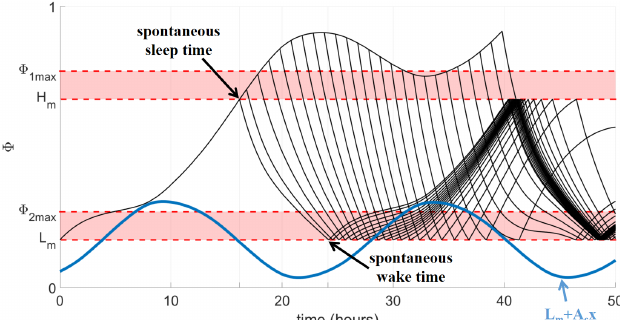
Figure 3. The time evolution of sleep propensity to the duration of sleep deprivation (valued as {0,1,...,24} h) beyond spontaneous sleep time. The red region demonstrated the feasible sleep propensity in tunable sleep schedule in following Equation (15). The black curves demonstrate the time evolution of simulated sleep propensity with various lengths of sleep deprivation. The blue curve plots the value of homeostasis at spontaneous wake times following sleep deprivation, i.e., L m + A c · x .